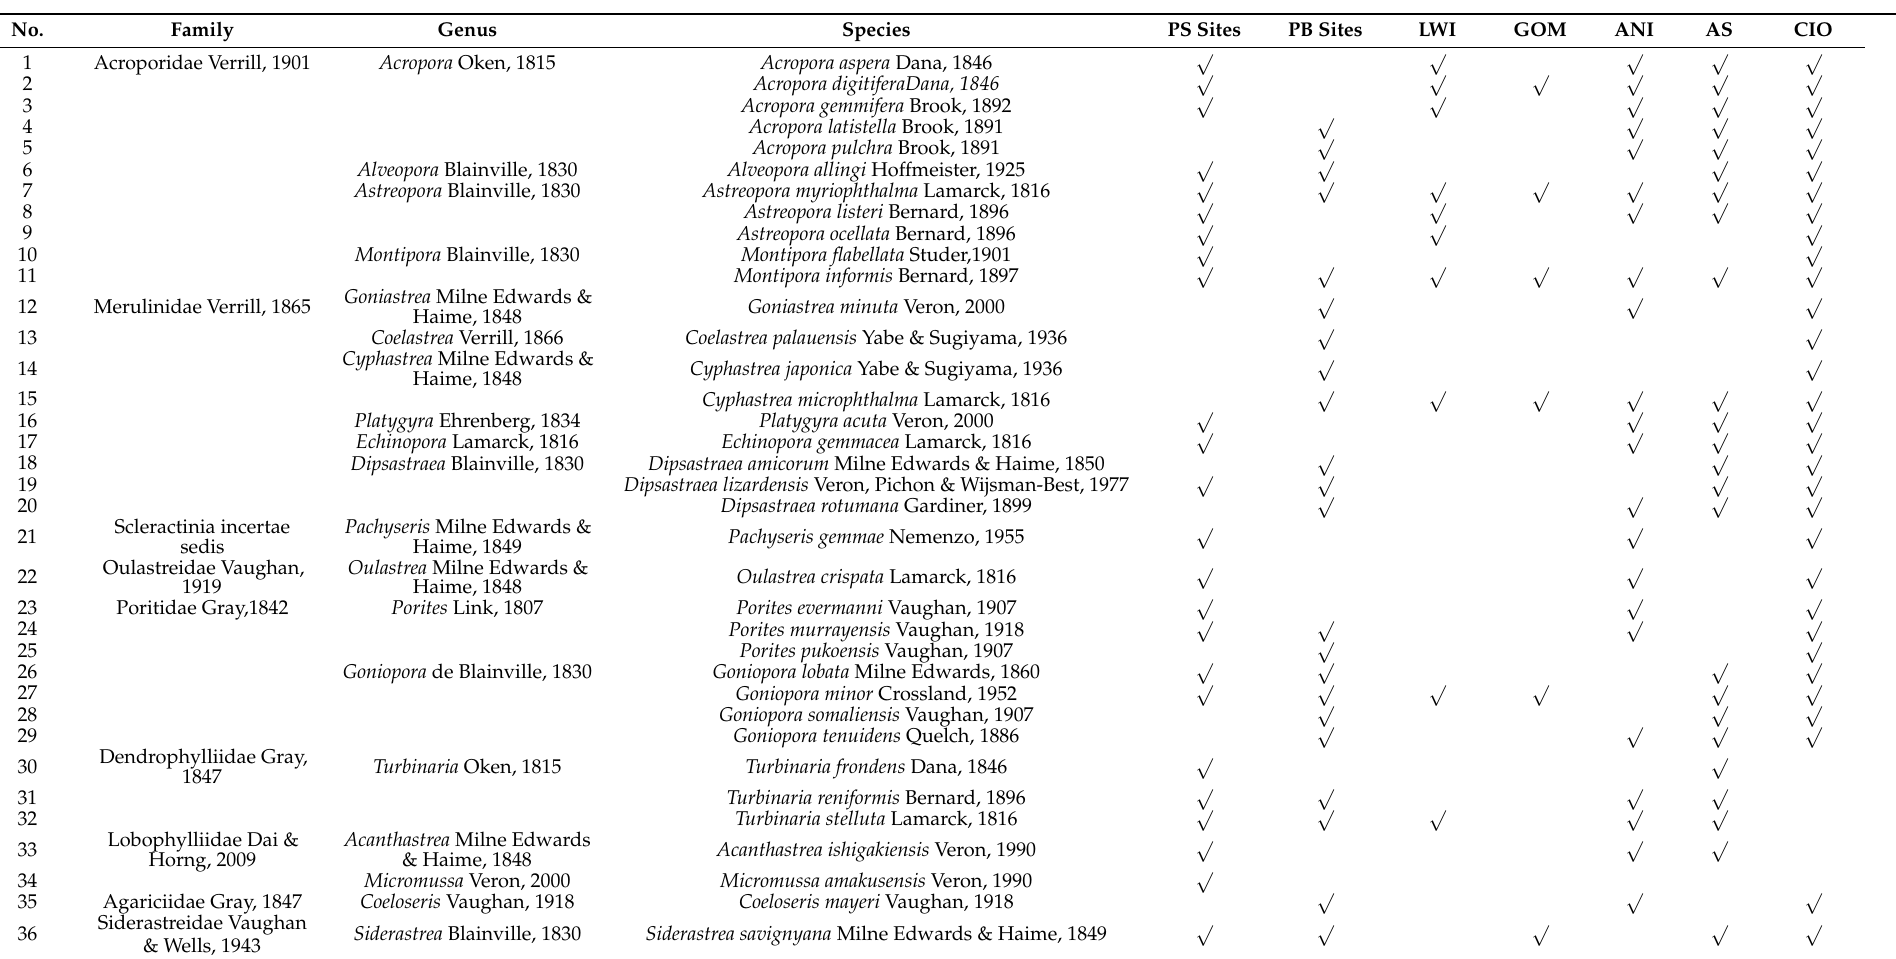
√ ) in other South Asia, Indian Ocean and Arabian Sea regions (LWI—Lakshadweep Islands,